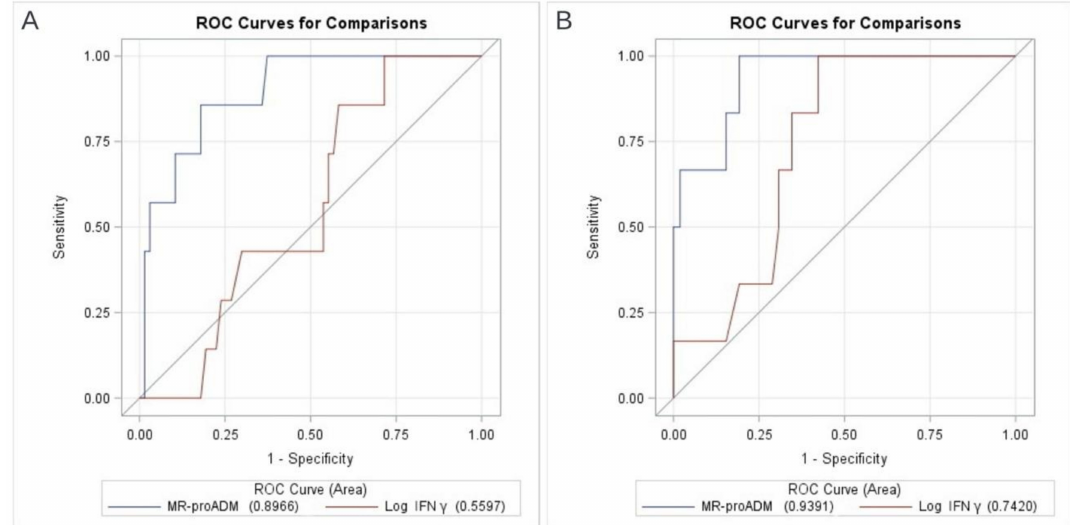
Figure 2. AUROC analysis of MR-proADM and in vitro IFN γ production for in-hospital mortality in the subgroup of non-vaccinated patients, at T0 (panel ( A )) and T1 (panel ( B